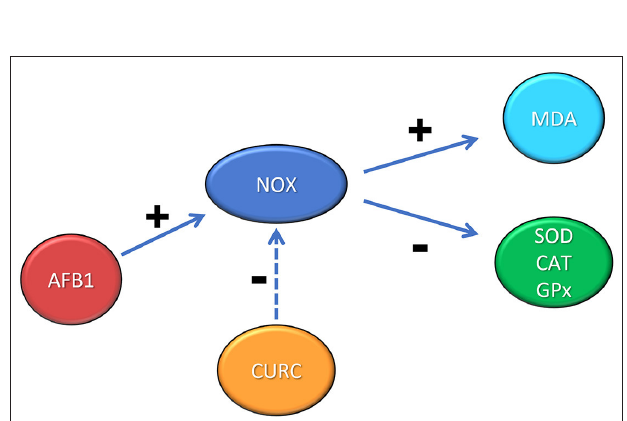
FIGURE 7 | Schematic representation of the role of NOX in the renal oxidative stress induced by AFB1 and the protective effect exerted by CURC. + : positive modulation; − : negative